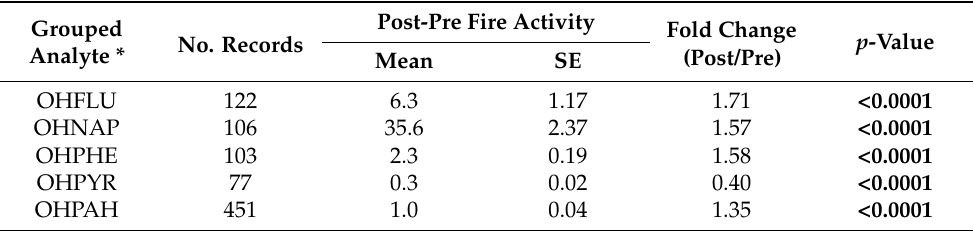
Table 2. Pre/post comparison of hydroxylated PAH (OHPAH) collected from urine samples (unit: ng/g—creatinine) by grouped analytes. Bold p -value indicates a statistically significant difference in urinary OHPAH levels after the fire activity. Post-Pre Fire Activity Fold Change Grouped p -Value No. Records Analyte * (Post/Pre) Mean SE OHFLU 122 OHNAP 106 35.6 <0.0001 103 451